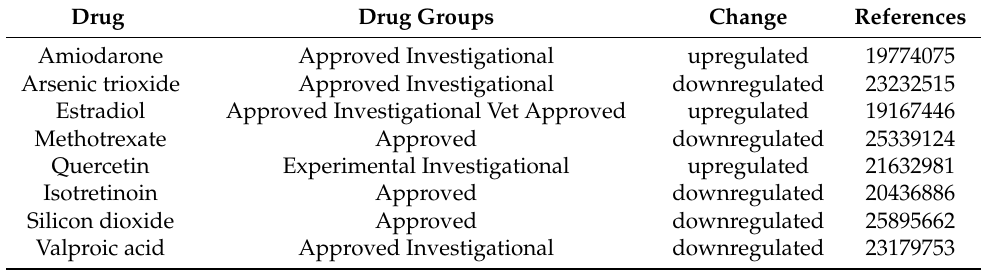
Table 8. Drugs that alter expression